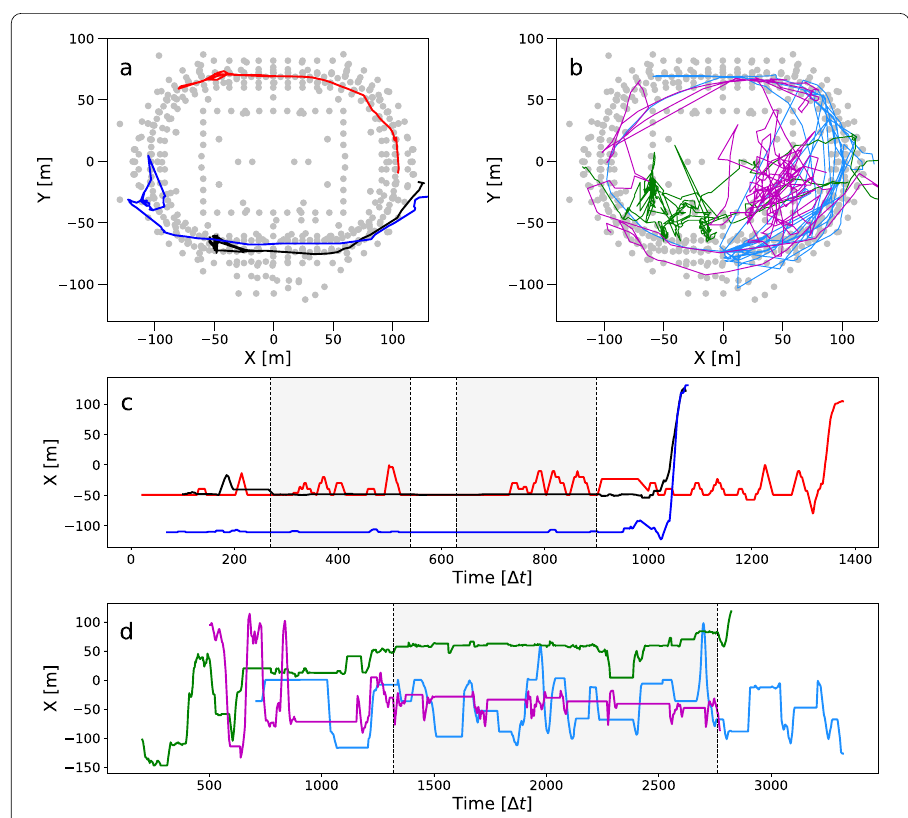
Figure 1 Examples of movement tracks during ( a ) the football match Ajax–Feyenoord, and ( b ) the Armin van Buuren dance event. ( c ), ( d ) The same movement tracks as 1D time series of projections on the x -axis (unit = (cid:2) t = 10 s). Grey areas between dotted vertical lines indicate start and end times of ( c ) the football match, and ( d ) the DJ